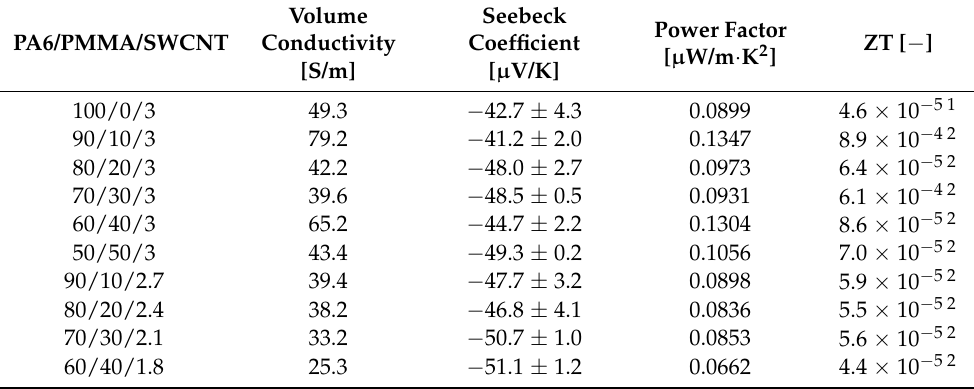
Table A3. TE parameters of PA6/PMMA/SWCNT